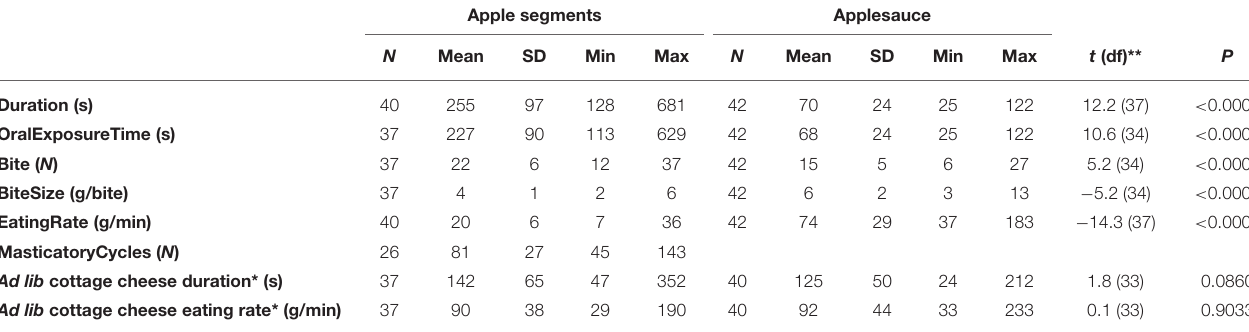
TABLE 4 | Oral processing behavior variables (videotape coding) when eating both preload types and cottage cheese. Apple segments